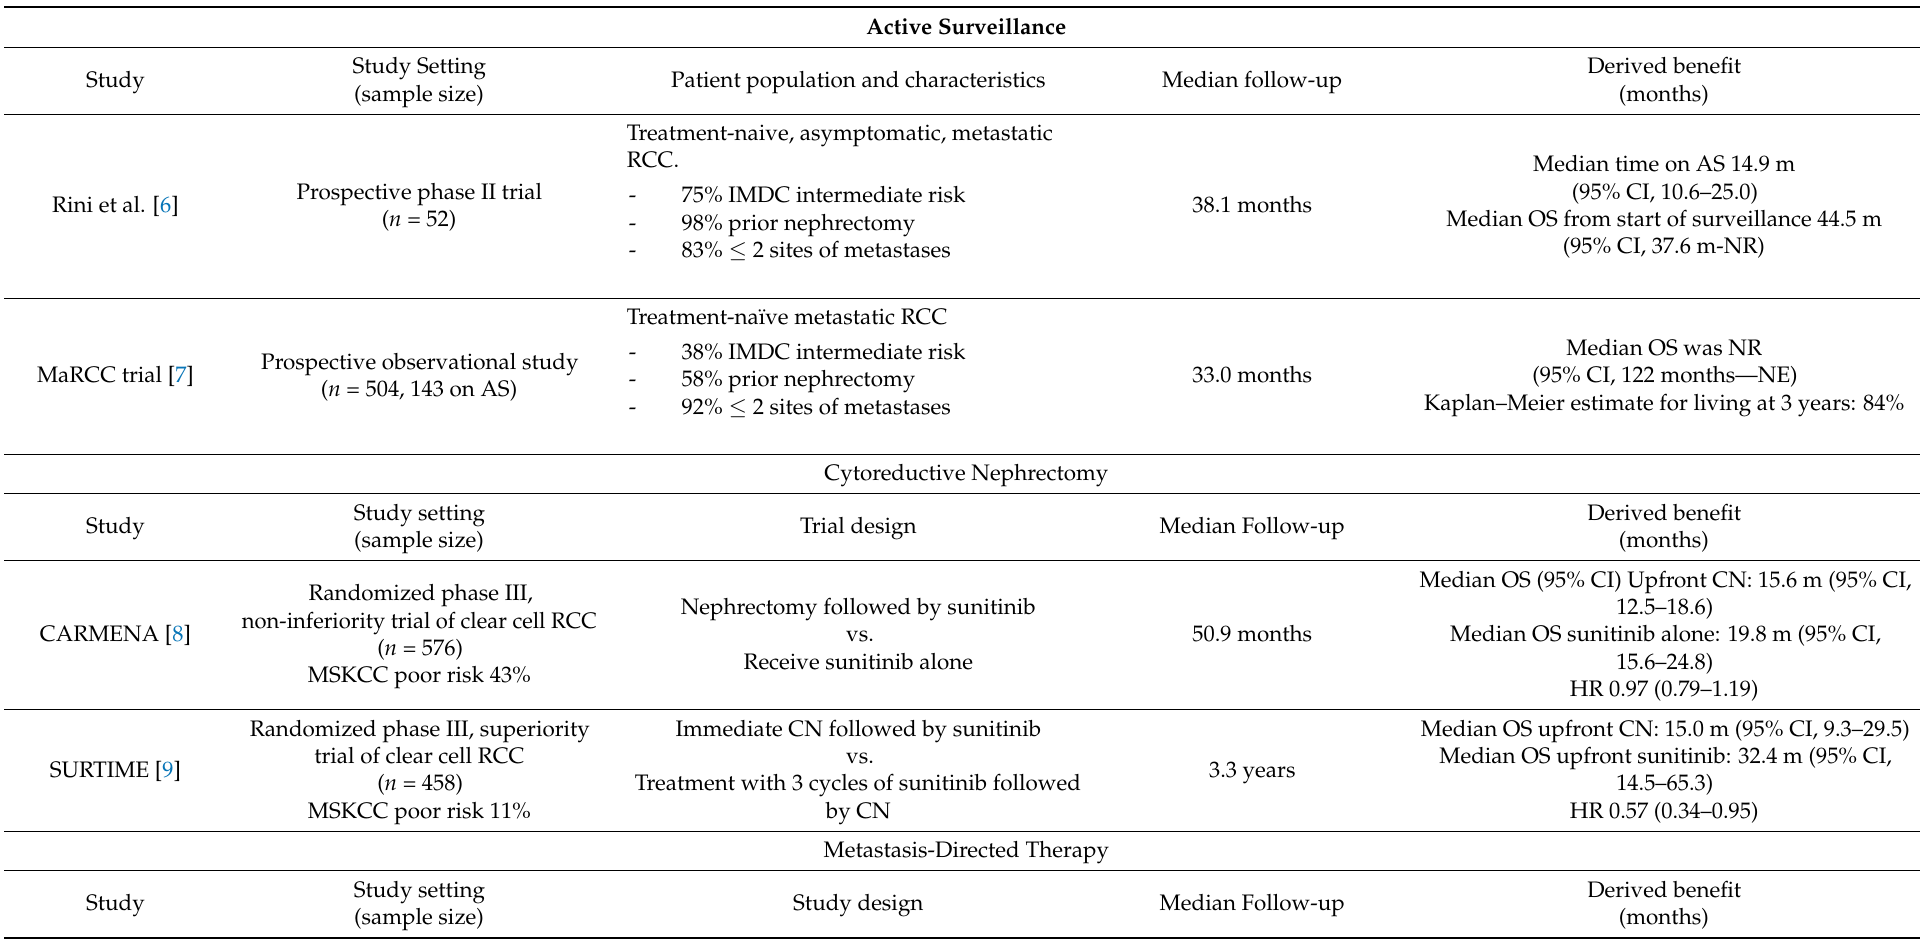
Table 1. Front-line approaches to metastatic RCC avoiding immediate initiation of systemic